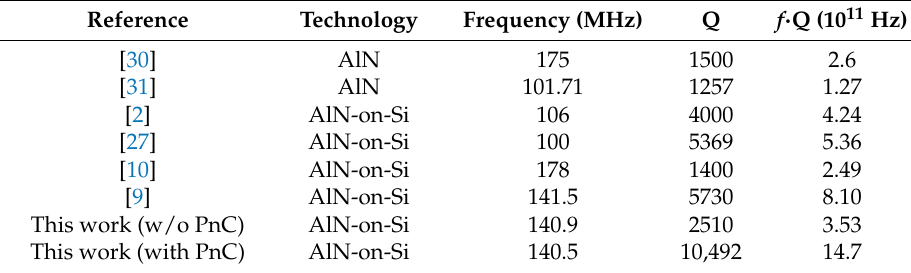
Table 2. Performance comparison of proposed PnC/resonator hybrids with the state-of-the-art piezoelectric AlN and AlN-on-Si resonators that share similar resonant frequencies. Reference